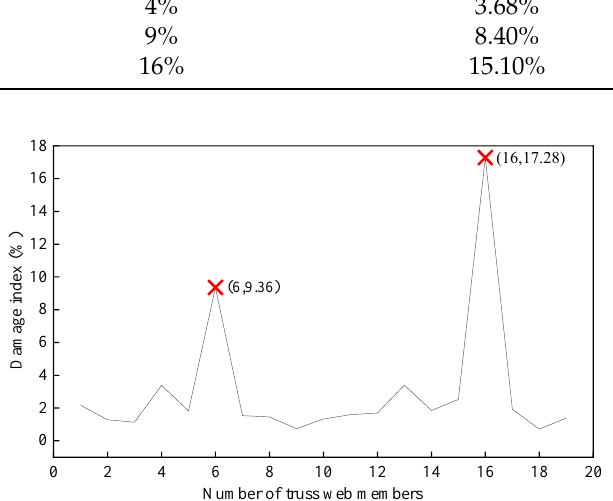
Figure 12. Results of multi-point damage detection under static loading.